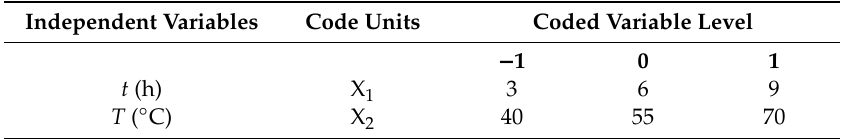
Table 1. Experimental values and coded levels of the central composite on-face experimental design